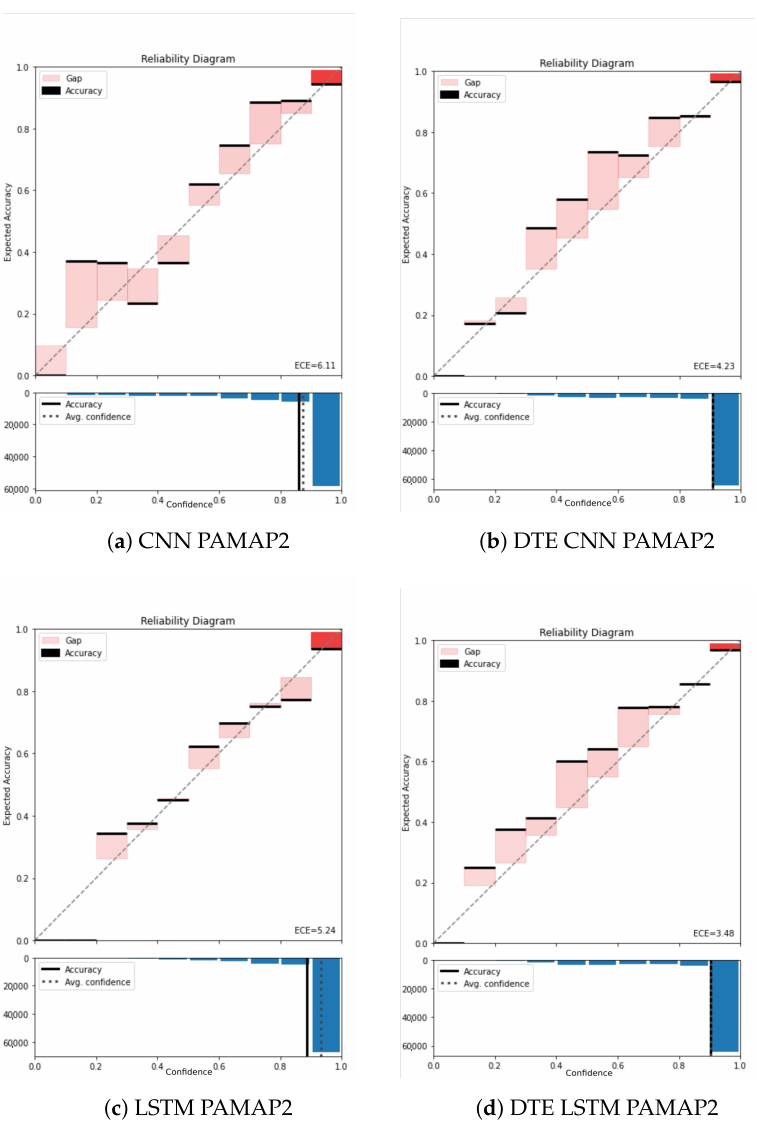
Figure A1. Reliability diagram of PAMAP2 for ( a ) CNN, ( b ) DTE CNN, ( c ) LSTM, and ( d ) DTE